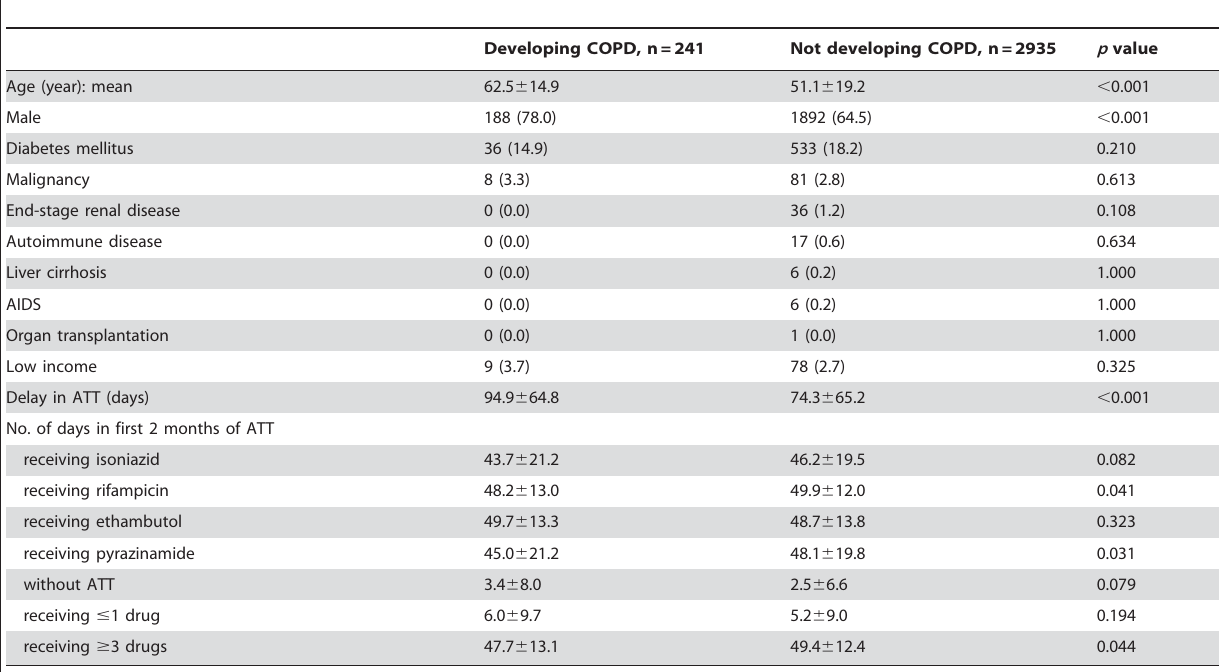
Table 4. Clinical characteristics at the initial study date of tuberculosis cases (n=3176) with or without subsequent chronic obstructive pulmonary disease.